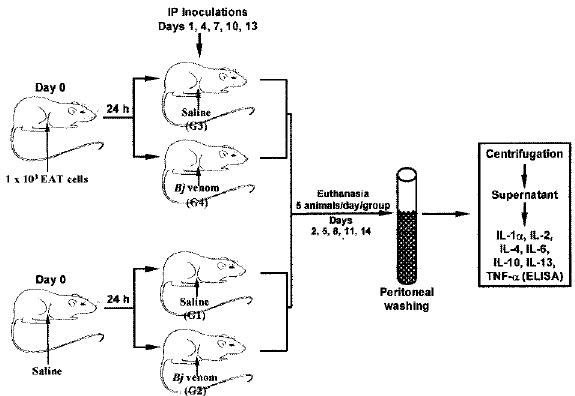
FIG. 1. Experimental design for evaluation of the cytokine profile of mice inoculated intraperitoneally (IP) with EAT cells and treated with Bj V (0.4mg/kg). ELISA, Enzyme-linked immunosorbent